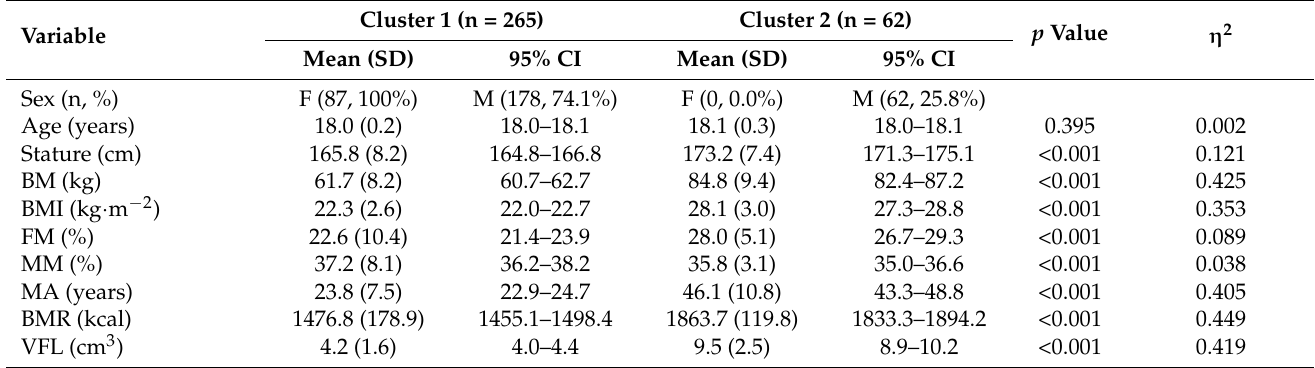
Table 3. Characteristics of the undergraduate students by identified profiles .